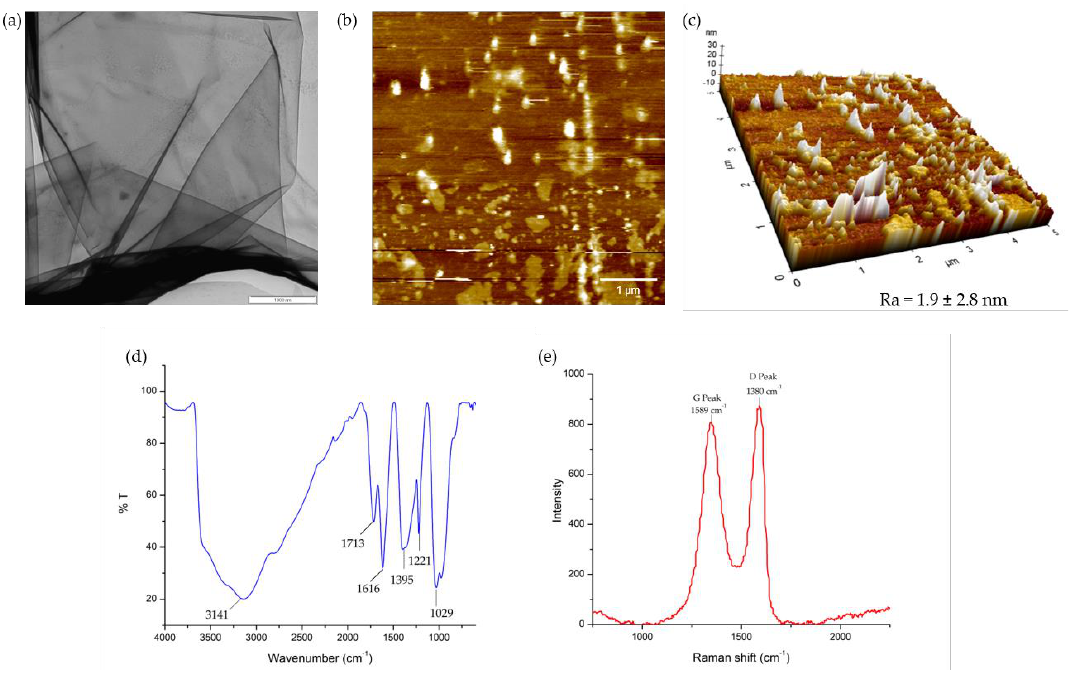
Figure 1. ( a ) TEM image of GO nanosheets at 10,000 magnification (scale bar: 1000 nm); ( b ) 2D AFM lateral images of GO at 5 µm (scale bar: 1 µm); ( c ) 3D AFM lateral images of GO at 5 µm; ( d ) ATR-FTIR spectrum of GO nanosheets; ( e ) Raman intensity of GO nanosheets.